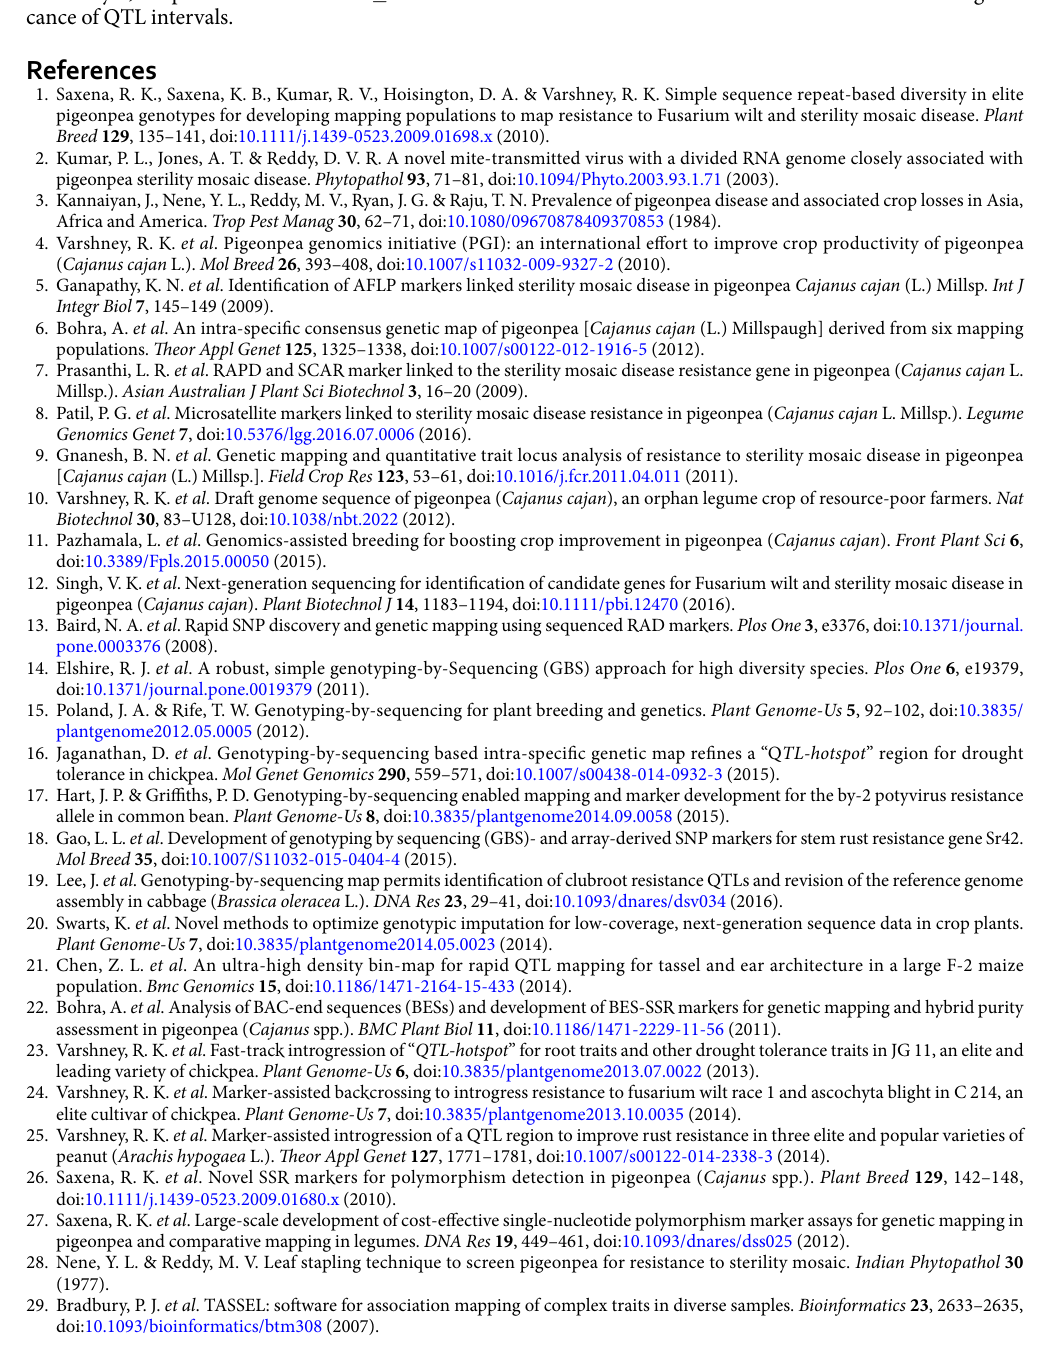
10. The SNPs identified were further filtered to remove missing data and such filtered SNPs were used for genetic mapping and QTL analysis. Genetic mapping and QTL analysis. The filtered SNPs from each population were used for the construc- tion of high density genetic maps using JoinMap V4.0 31 . The Chi-square ( χ 2 ) values calculated for each SNP marker using Joinmap V4.0 were used to determine segregation distortion and highly distorted and unlinked markers were excluded from further analysis. The grouping and ordering of markers was carried out using regres- sion mapping algorithm with maximum recombination frequency of 0.4 at minimum logarithm of odds (LOD) value of 3. The marker orders after incorporation of new marker was confirmed using ripple command. Finally, Kosambi mapping function was used to convert recombination fraction into map units 32 . Mapchart 2.30 33 was used for the visualization of the linkage groups. The genotyping data along with phenotyping data collected for each population were used for QTL analysis using QTL Cartographer V.2.5 software 34 . The composite interval mapping (CIM) method with model 6 and other default values were used for QTL identification. The empirical LOD thresholds for each trait were deter- mined by 1,000 permutations at the P ≤ 0.05 level 35 . The LOD score values were used to determine the signifi- cance of QTL